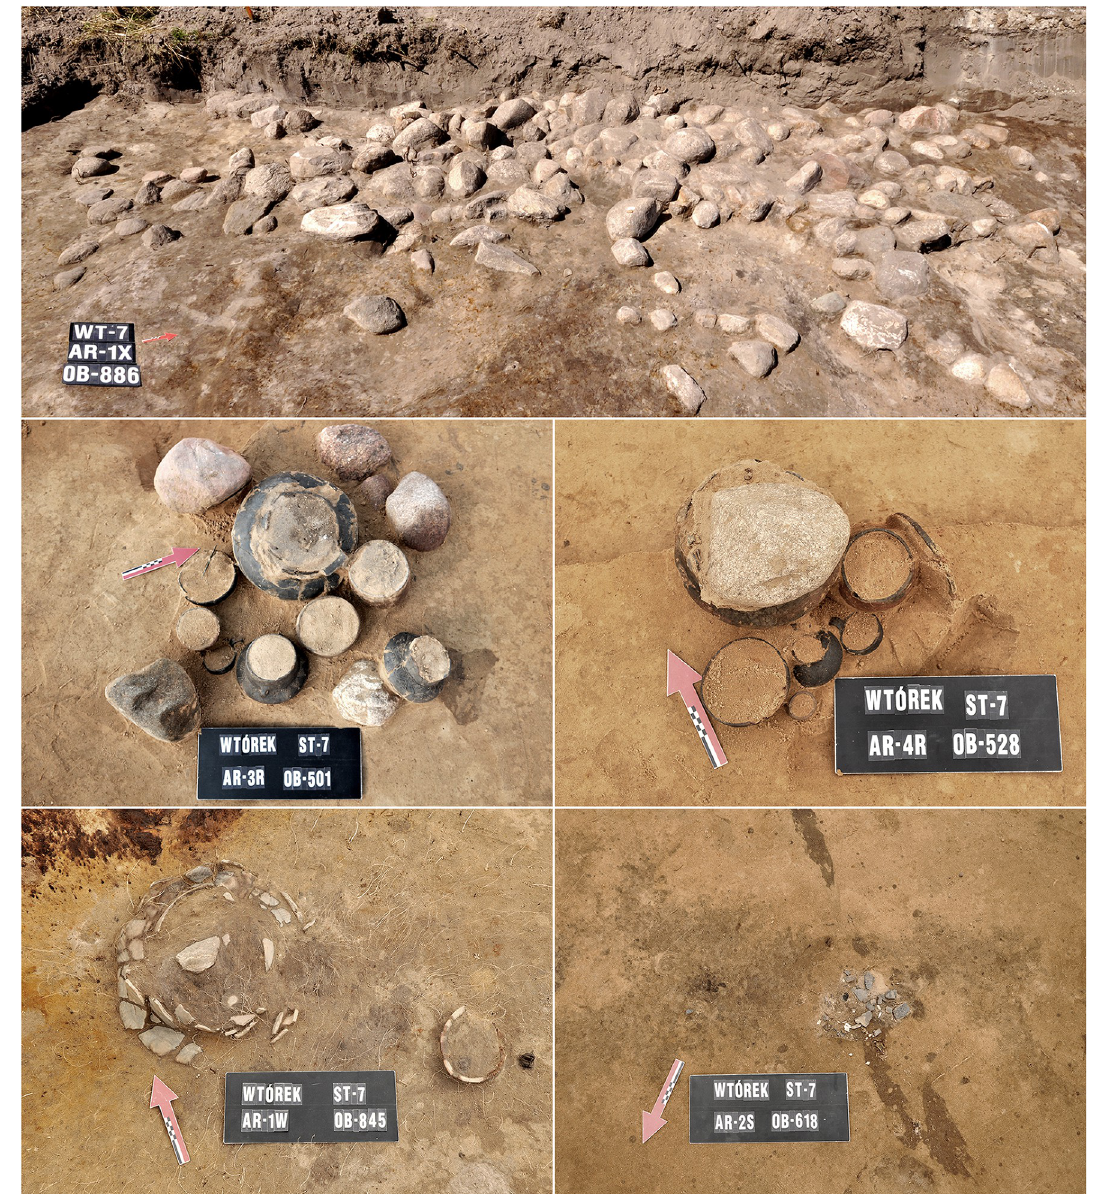
Fig 1. Burials in situ at the cemetery in Wto´rek, Greater Poland, Poland. At the top, stone pavement covering the grave 886. In the middle row—well-preserved graves 501 and 528, and at the bottom—poorly preserved burial 845 and very badly preserved burial